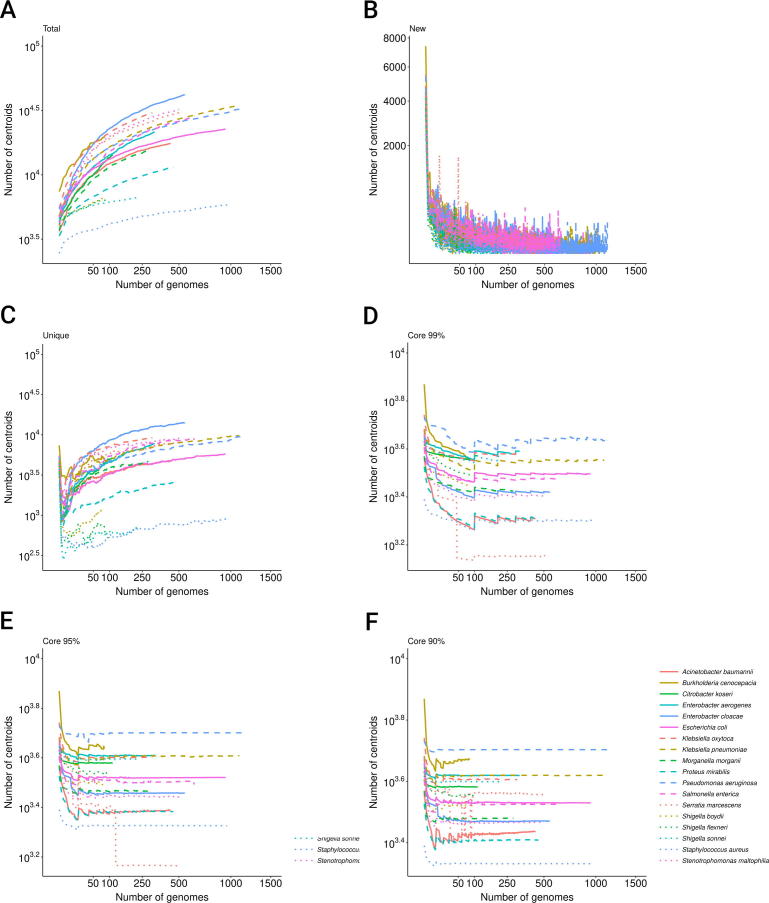
Estimated centroid rates for all pan-genomes The plots show the centroid rates of all (A), unique (B), new (C), and core (99%, 95%, and 90%) centroids (D–F) as a function of the number of genomes (isolates) included in the pan-genome. The rates were estimated from 100 permutations of the centroid presence/absence matrices as the median value over all permutations performed.